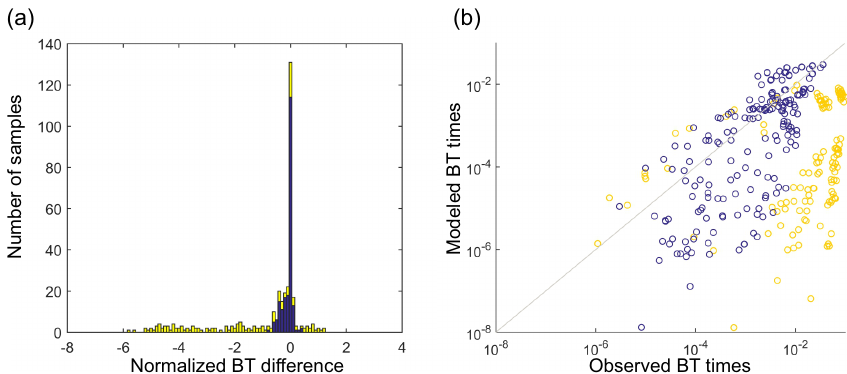
Figure 7. (a) Histogram plot of absolute differences of breakthrough times between the inverted and the original model (192 samples normalized to the mean of the breakthrough times). Yellow color marks the known outliers, such as observation points in the top low- K zone and the far end of the domain. (b) Scatterplot of observed and simulated breakthrough